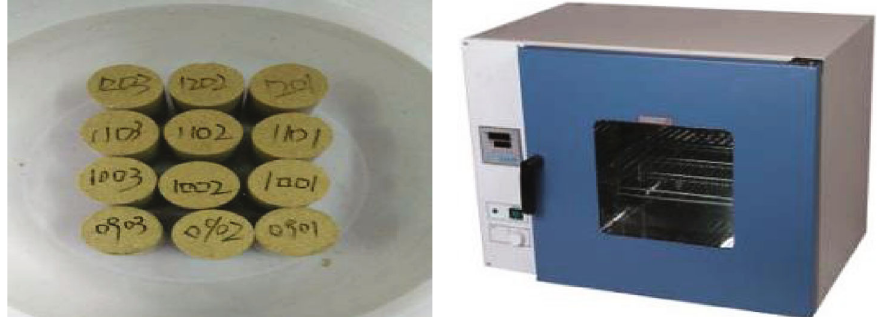
Figure 3: Hydrophilicity